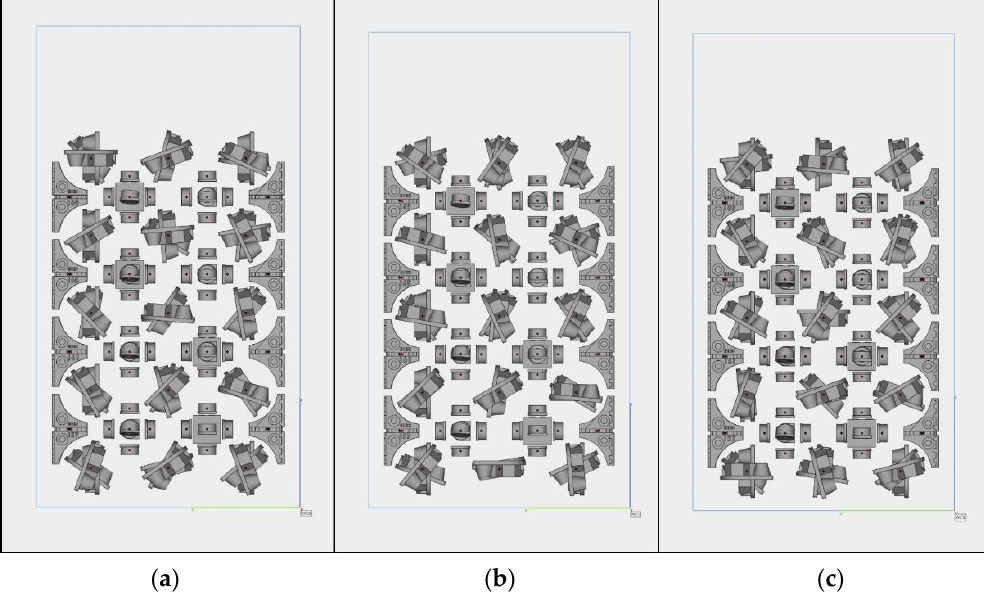
Figure 13. Build layout in Magics 23.01 for all three builds as seen from the left. ( a ) Build 1; ( b ) build 2; ( c ) build 3.